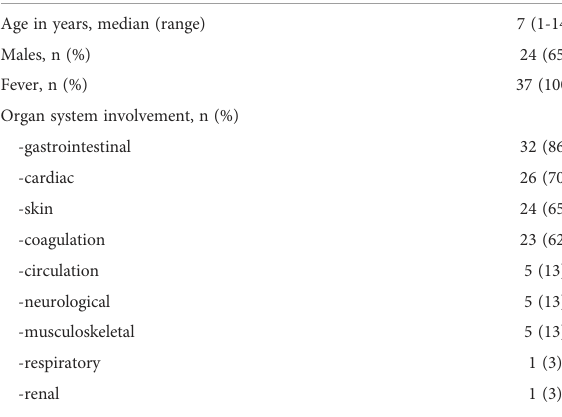
TABLE 1 Demographics and clinical features of the 37 patients with MIS-C. Age in years, median